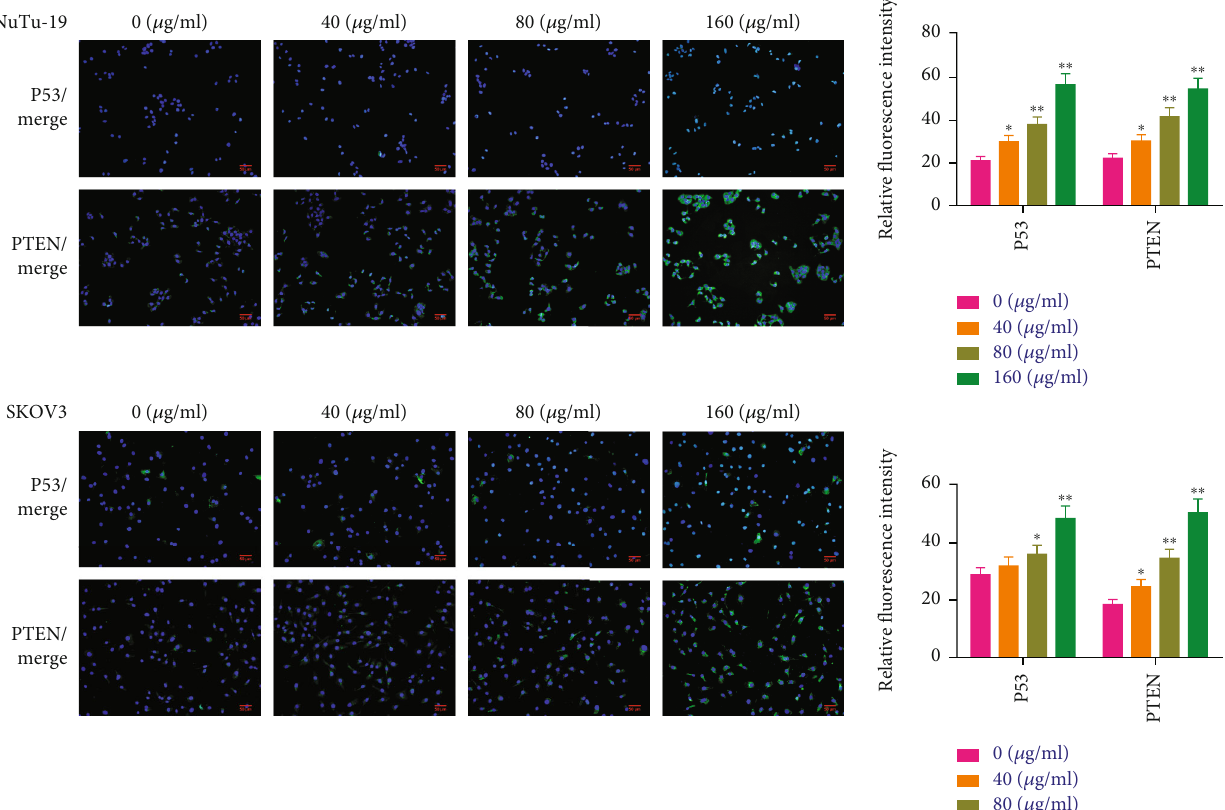
Figure 2: Puerarin activates the expression of P53 and PTEN in OC cell lines of NuTu-19 and SKOV3. The expression of P53 and PTEN in NuTu-19 and SKOV3 cells was detected by an immuno fl uorescence assay. The data are presented as mean ± SD , n = 3 . ∗ p < 0 : 05 , ∗∗ p < 0 : 01 , compared to the 0 μ g/mL puerarin group. OC: ovarian